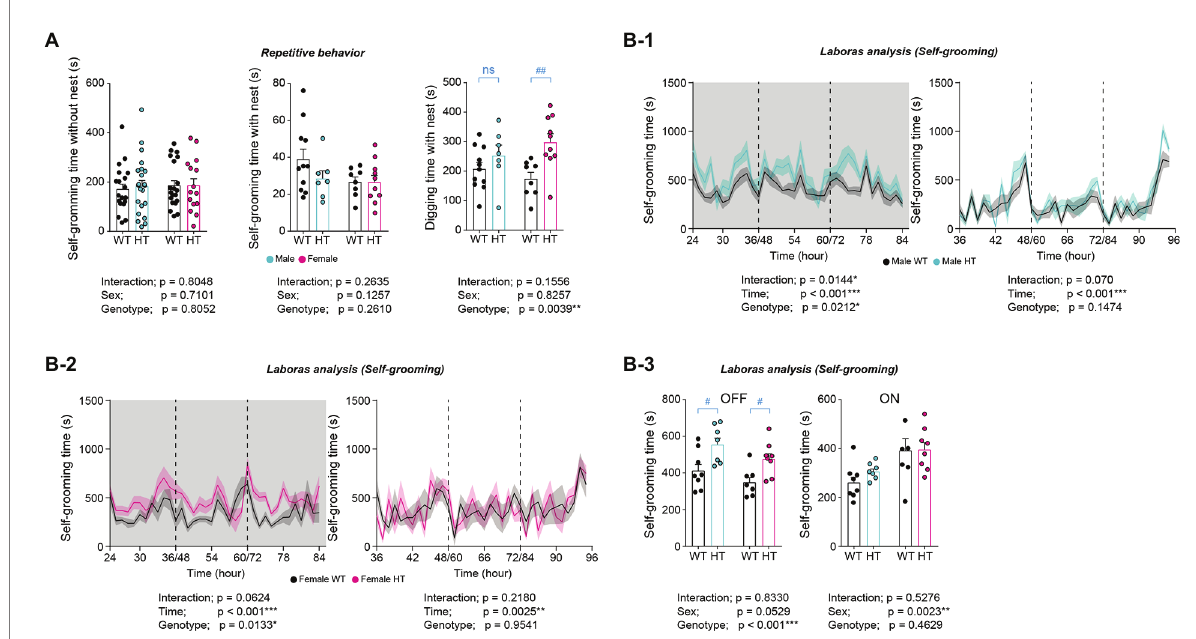
FIGURE 5 Differential increases in repetitive behaviors in adult male and female Chd8 +/S62X mice. (A) Normal self-grooming but altered digging behaviors in male and female Chd8 +/S62X mice (3–4 months) in novel home cages compared with WT mice. ( n = 11 mice [male-WT], 7 [male-HT], 8 [female-WT], and 10 [female-HT], ** p < 0.01, two-way ANOVA, ## p < 0.01, ns, not significant, Mann–Whitney U test and Student’s t -test). (B) Similarly increased self-grooming in LABORAS cages (a familiar environment) in adult male and female Chd8 +/S62X mice (2 months), compared with WT mice. Light-off and light-on phases, which were pooled from the three-day recordings, are indicated in grey and white backgrounds, respectively. ( n = 8 mice [male-WT], 7 [male-HT], 7 [female-WT], and 8 [female-HT], * p < 0.05, ** p < 0.01, *** p < 0.001, two-way repeated-measures/RM-ANOVA with Holm- Sidak test [B-1-B-3], # p < 0.05, Mann–Whitney U test